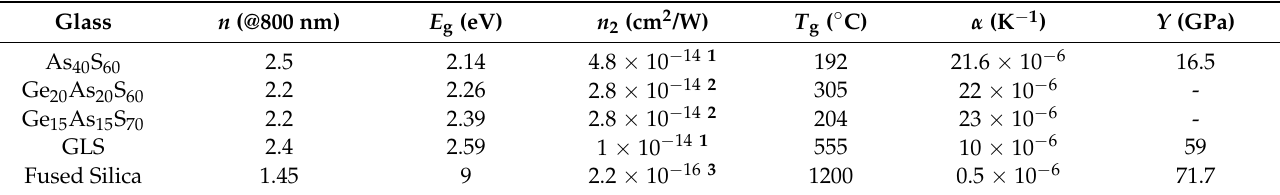
Table 1. Refractive index ( n ), band-gap ( E g ), nonlinear index ( n 2 ), glass transition temperature ( T g ), thermal expansion coefficient ( α ), and Young modulus ( Y ) of the four chalcogenide samples considered in this study. The same parameters for fused silica are also given for